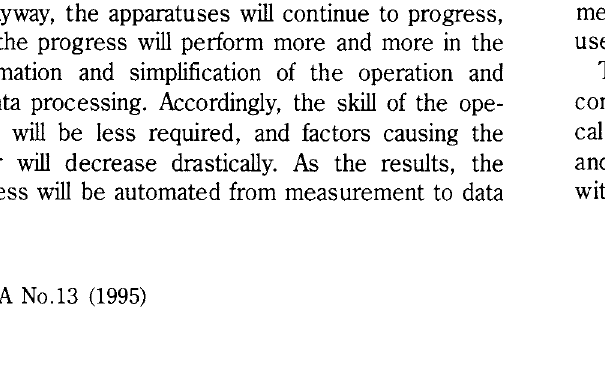
Fig. 18 Results of silica particles (SP14H) by laser diffraction and scattering method (solid line: 9 models, 12 results) and photon correlation method (dotted line: 1